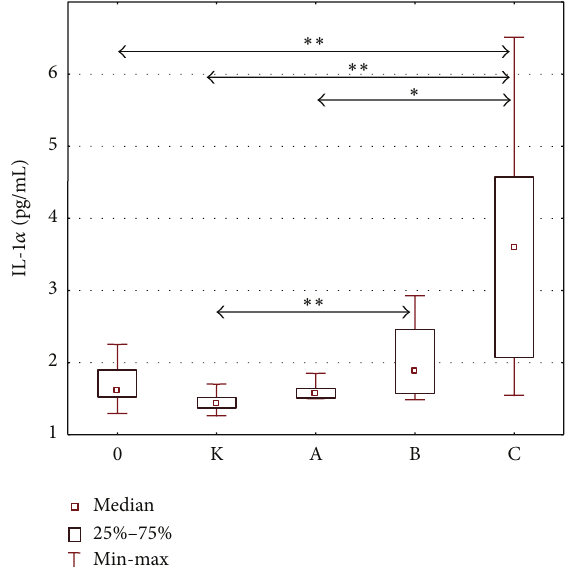
Figure 2: IL-1 𝛼 concentration (pg/mL) in the serum of alcoholics without liver cirrhosis (0), alcoholics with liver cirrhosis (stages A, B, and C), and healthy controls (K). Key: ∗ 𝑝 < 0.05 and ∗∗ 𝑝 < 0.001 .